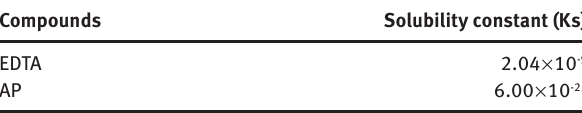
Table 1: Chemical stability constants of EDTA and AP at 25 ° C.